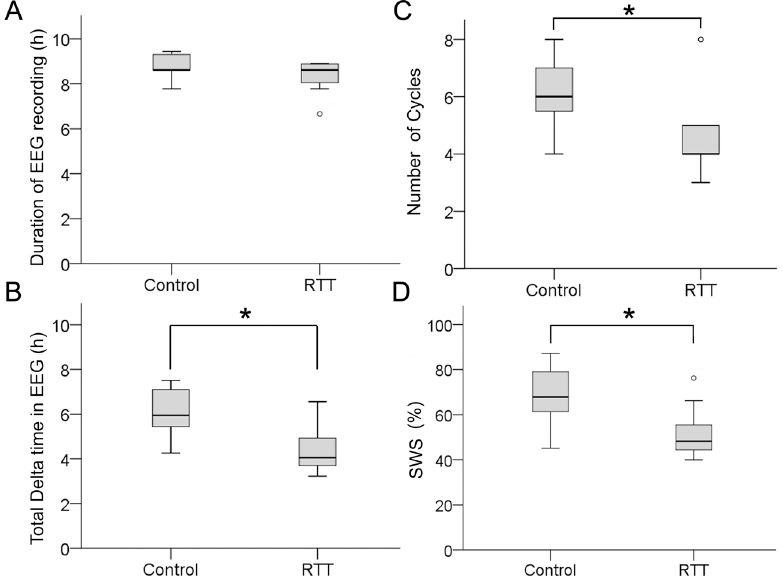
Fig 1. Boxplot of EEG spectral analysis and sleep structure analysis (A). Comparison of duration of overnight recordings in control EEGs with RTT EEGs revealed no significant differences. (B) Patients